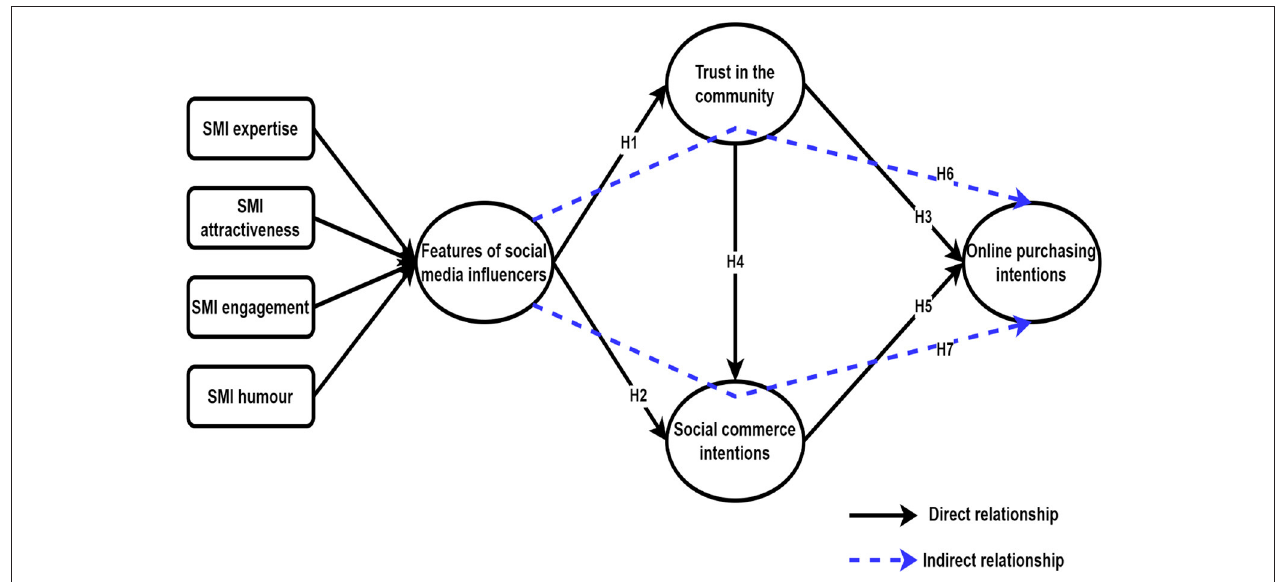
FIGURE 1 | Conceptual framework.